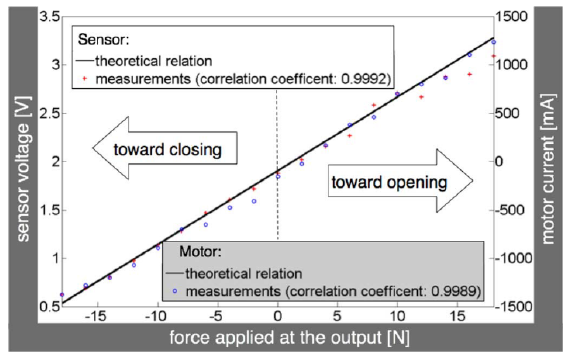
Figure 16. Theoretical and actual measurements of motor current required to maintain the position of a chosen finger, in this case the middle finger